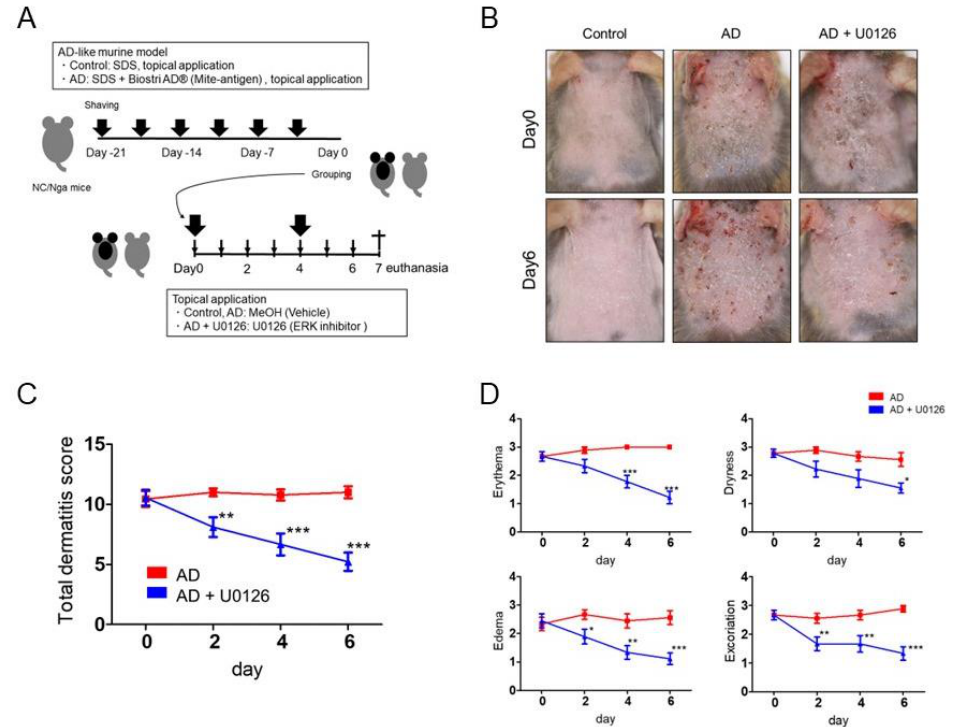
Figure 2. Topical application of ERK inhibitor alleviates the clinical symptoms of mite antigen-induced AD in NC/Nga mice. ( A ) Schema of induction of mite antigen-induced AD-like murine model. After 2 h treated with 4% SDS, mite antigen, Dermatophagoides farinae extract (Biostir AD ® ), was epicutaneously applied to the upper back and ear skin of mice twice a week for three weeks to develop AD. These mice were then topically treated with ERK inhibitor or vehicle for 7 days on the same site. ( B ) Macroscopic features of skin lesions of control, AD, and AD + U0126 groups on day 0 and 6. ( C , D ) Total dermatitis score ( C ) and all dermatitis scores such as erythema, dryness, edema, and excoriation ( D ) were assessed on day 0, 2, 4, and 6. All data are presented as mean ± S.E.M. (n = 9 per group). * p < 0.05, ** p < 0.01, *** p < 0.001 Student’s unpaired two -tailed t-test on each day.